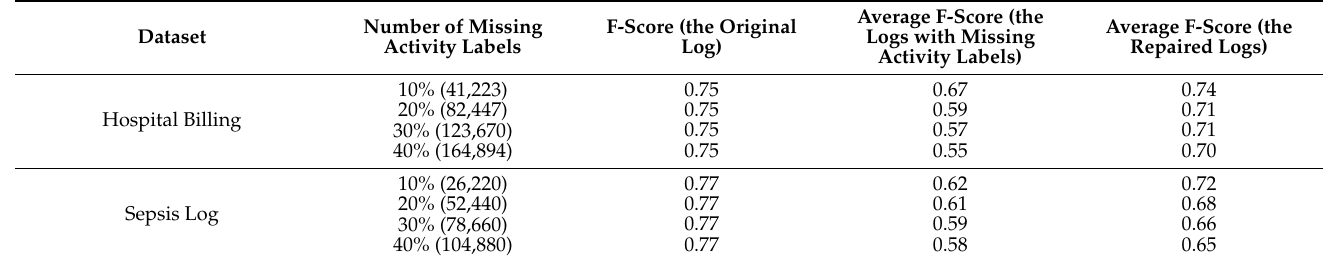
Table 10. F-scores of process models discovered by the inductive miner (infrequent) from the original, problem and repaired event logs. All conformance checking was conducted between discovered process models and the original event logs.